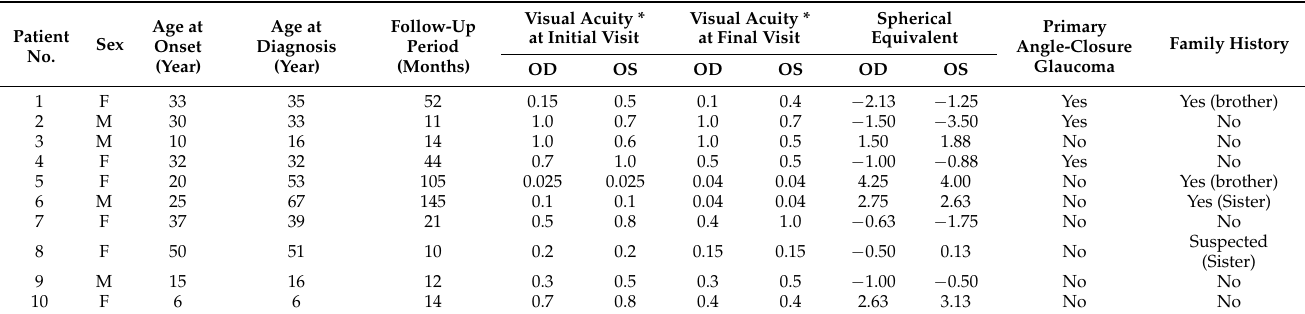
Table 1. Baseline characteristics.